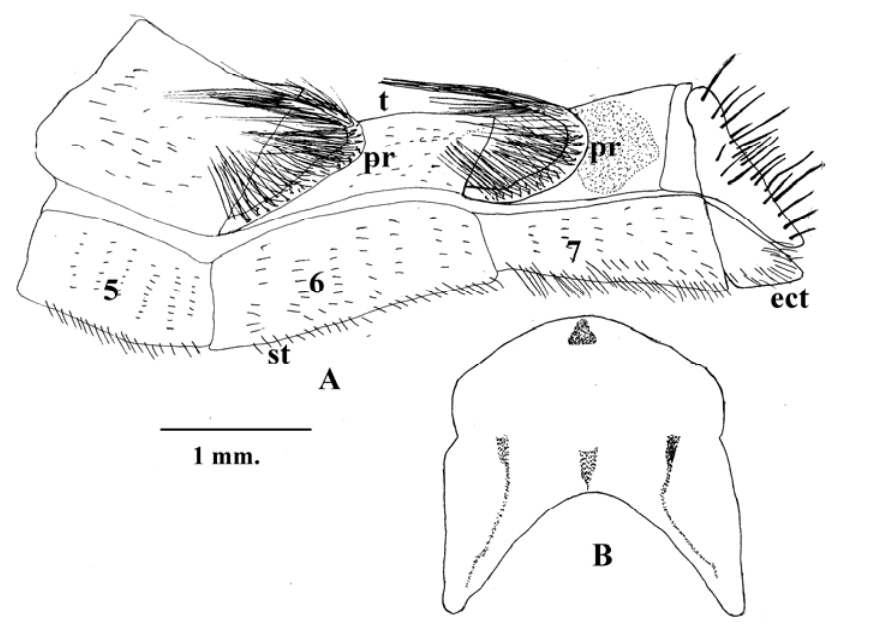
FIG . 9.- Myrmecaelurus trigrammus . A; abdomen, 6,7,8;abdominal segments 5,6,7. pr; abdominal processes with long tufts of hair,t; tergum, st; sternum.epi; epiproct.